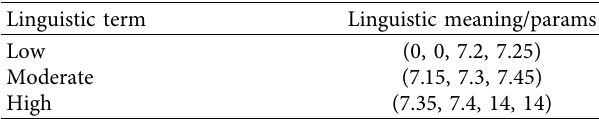
Table 5: pH linguistic terms